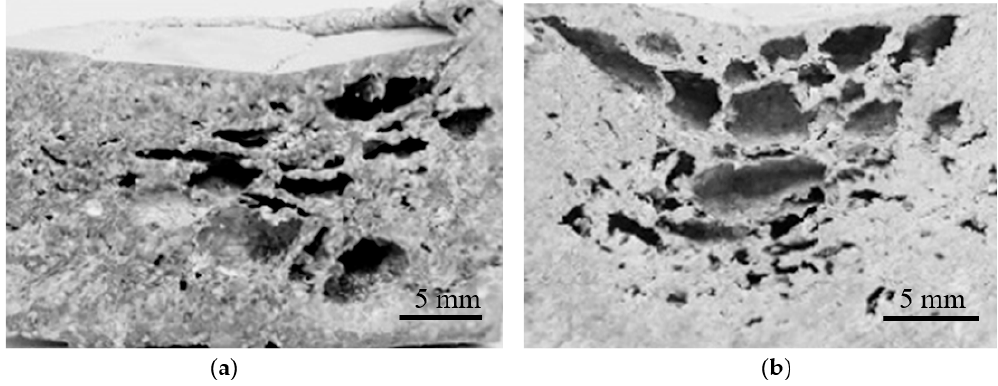
Figure 6. Macrostructures of Al–5Ni foams with 3 wt.% ( a ) and 10 wt.% ( b ) dolomite additions.